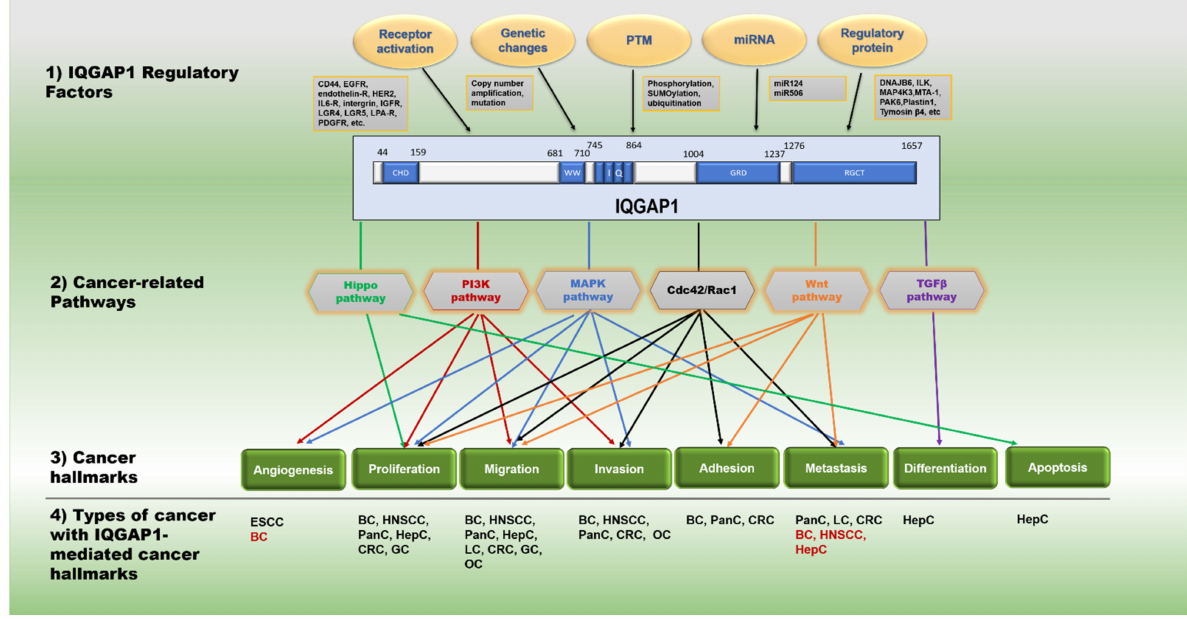
Figure 2. Roles of IQGAP1 in cancer development. ( 1 ) IQGAP1 regulatory factors: IQGAP1 (cid:48) s activity can be regulated by different cancer development factors, including the genetic changes to the IQGAP1 gene, post-translational modifications on the IQGAP1 protein, activations of signaling receptors, miRNA, or other non-receptor regulatory proteins. Example candidates in each category are summarized in the gray rectangles. ( 2 ) The IQGAP1 protein: a schematic diagram of human IQGAP1 protein, with each of the five main binding domains highlighted in blue and the numbers above indicating amino acid positions for each domain. ( 3 ) Cancer-related pathways and cancer hallmarks: list of IQGAP1-mediated pathways and related cancer hallmark events. The pathways and the pathway-regulated hallmarks are color-coded. Dash line indicates a connection between IQGAP1 and this cancer hallmark, but no mechanism is proposed. ( 4 ) Types of cancer with IQGAP1-mediated cancer hallmarks: BC, breast cancer; CRC, colorectal cancer; ESCC, esophageal squamous cell carcinoma; GC, gastric cancer; HepC, hepatic cancer/liver cancer; HNSCC, head and neck squamous cell carcinoma; LC, lung cancer; OC, ovarian cancer; PanC, pancreatic cancer. Black font indicates that IQGAP1 has been reported to regulate this hallmark through at least one proposed mechanism in this type of cancer; red font indicates that IQGAP1 has been reported to regulate this hallmark in this cancer, but no clear mechanism has been